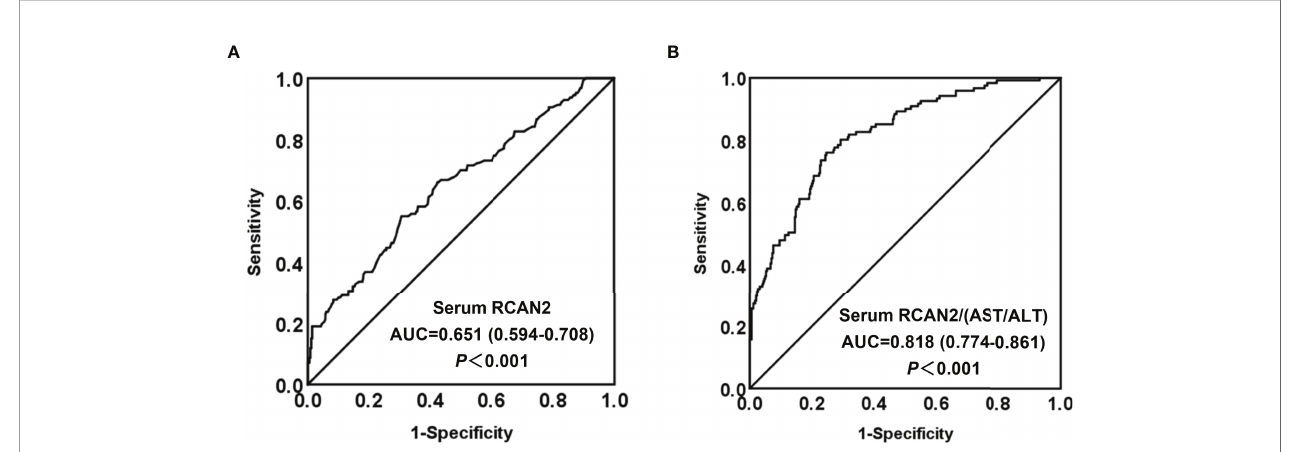
FIGURE 3 | Comparison for ROC curve analysis of serum RCAN2 (A) , serum RCAN2/(AST/ALT) (B) in participants with OB and NW. ROC curves were derived by plotting the relationship between the speci fi city and the sensitivity at various cut off concentrations. ROC, receiver-operating characteristic; AUC, area under the curve.